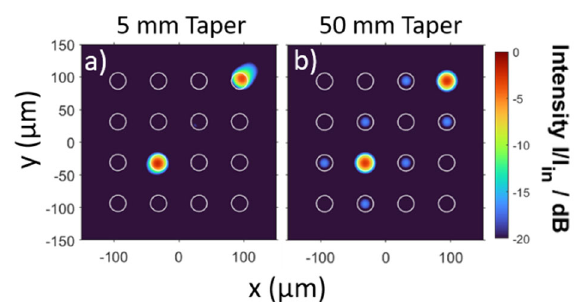
Fig. 3. Final intensity distributions of a) a 5 mm MCF taper and b) a 50 mm MCF